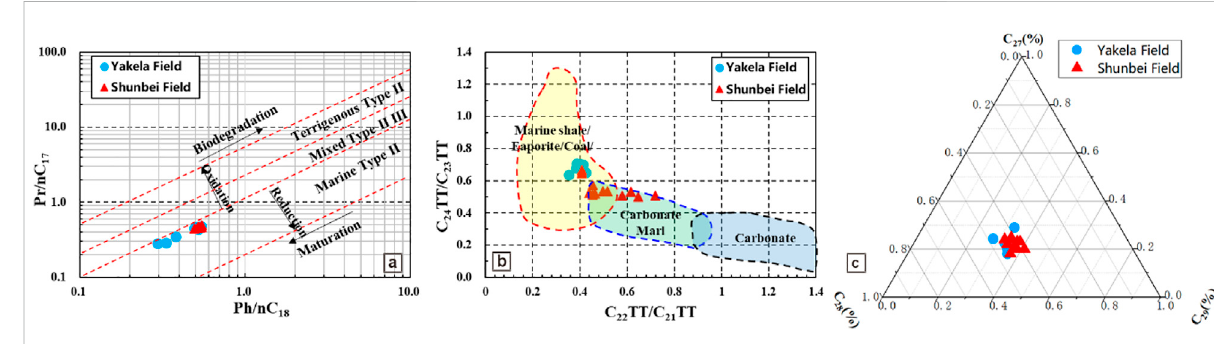
FIGURE 3 Cross plots of biomarker ratios: (A) Pr/nC 17 vs. Ph/nC 18 ; (B) C 24 TT/C 23 TT vs. C 22 TT/C 21 TT; (C) Triangular plot of the normalized relative abundances of